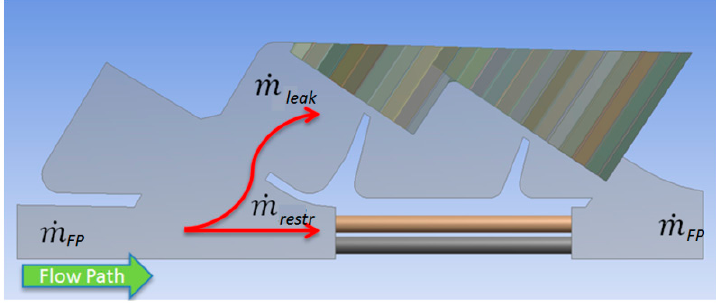
Figure 12. Mass flow split for the CFD model.